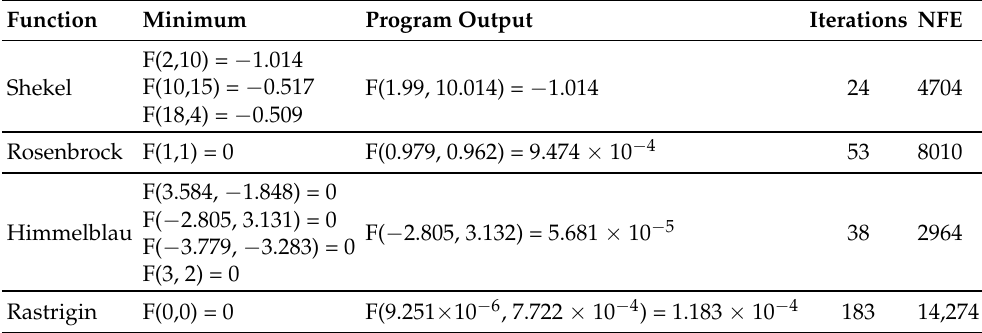
Table 3. The standard bees algorithm.